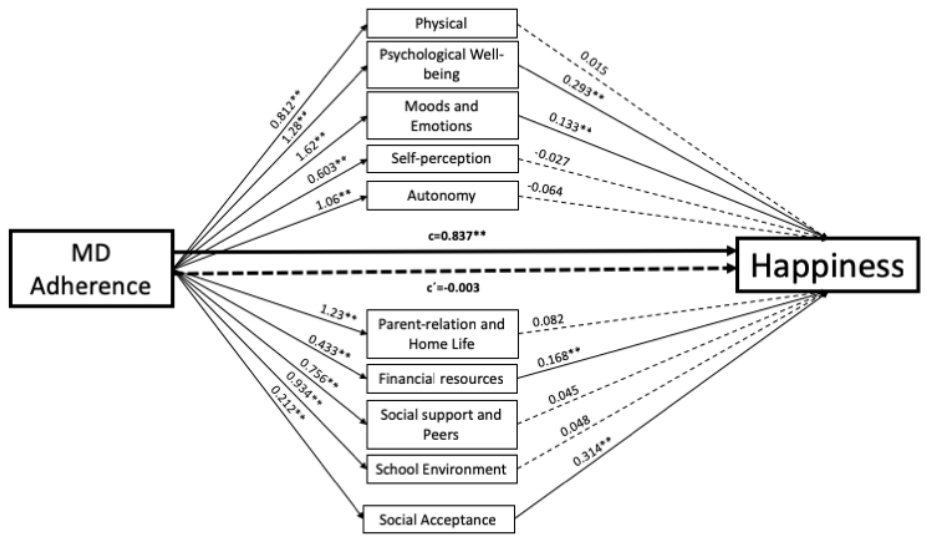
Figure 1. Mediation model testing the indirect association between adherence to a Mediterranean diet (MD) and happiness through the effects of each dimension of HRQOL. Dashed paths are non-significant. (* p < 0.05; ** p < 0.01) .